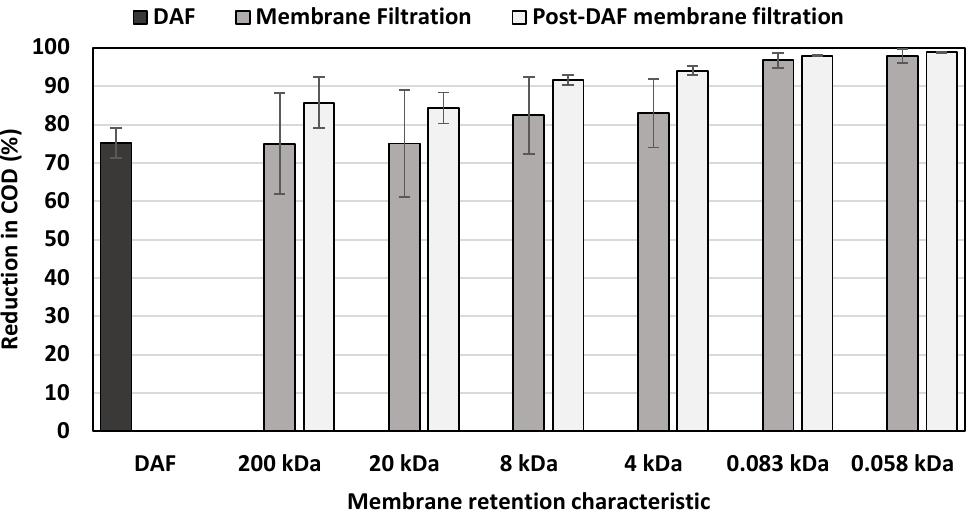
Figure 6. Percent reduction in COD across various treatment methods.